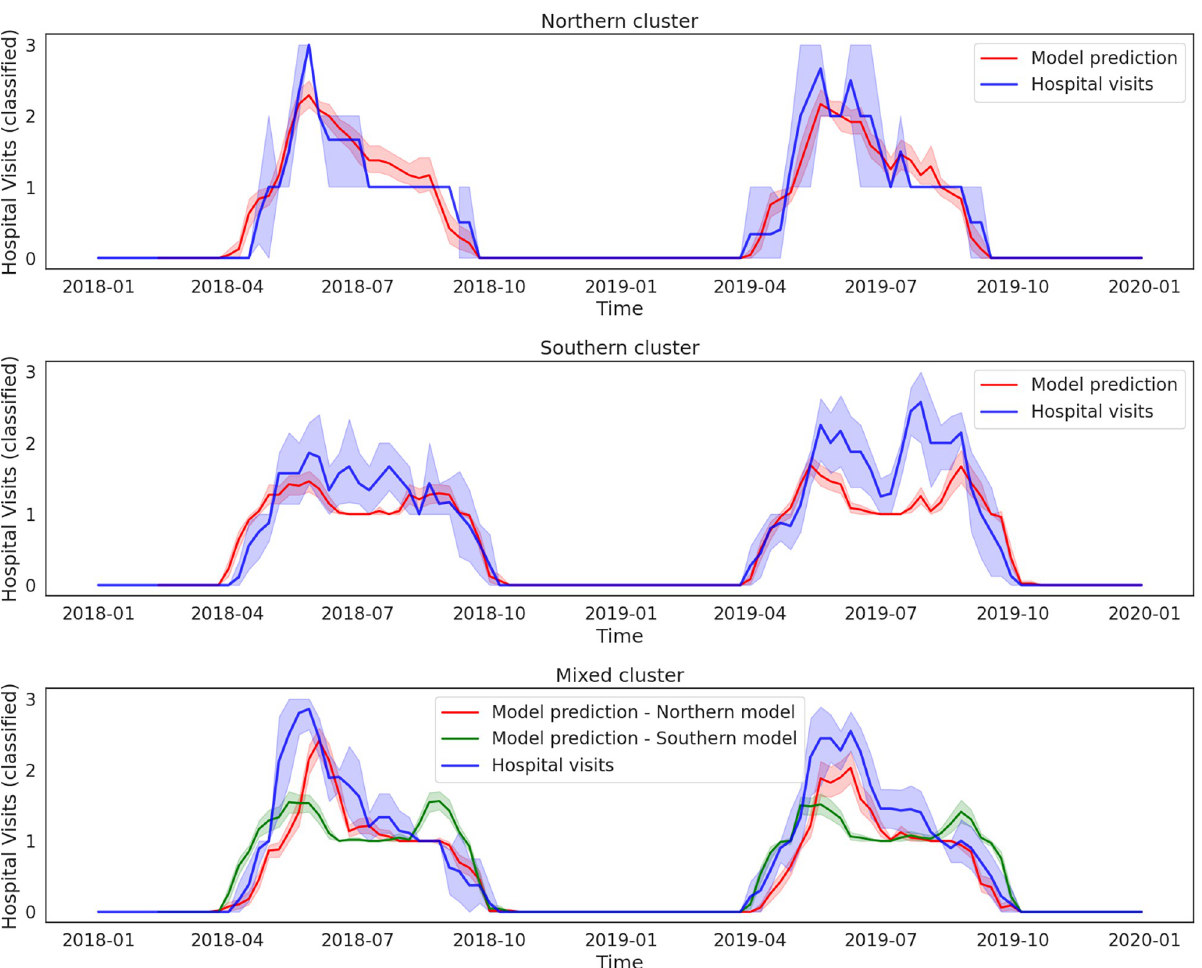
Fig 6. Model prediction and classified tick related hospital visits time series for the Northern cluster (top panel), Southern cluster (middle panel) and mixed cluster (bottom panel).